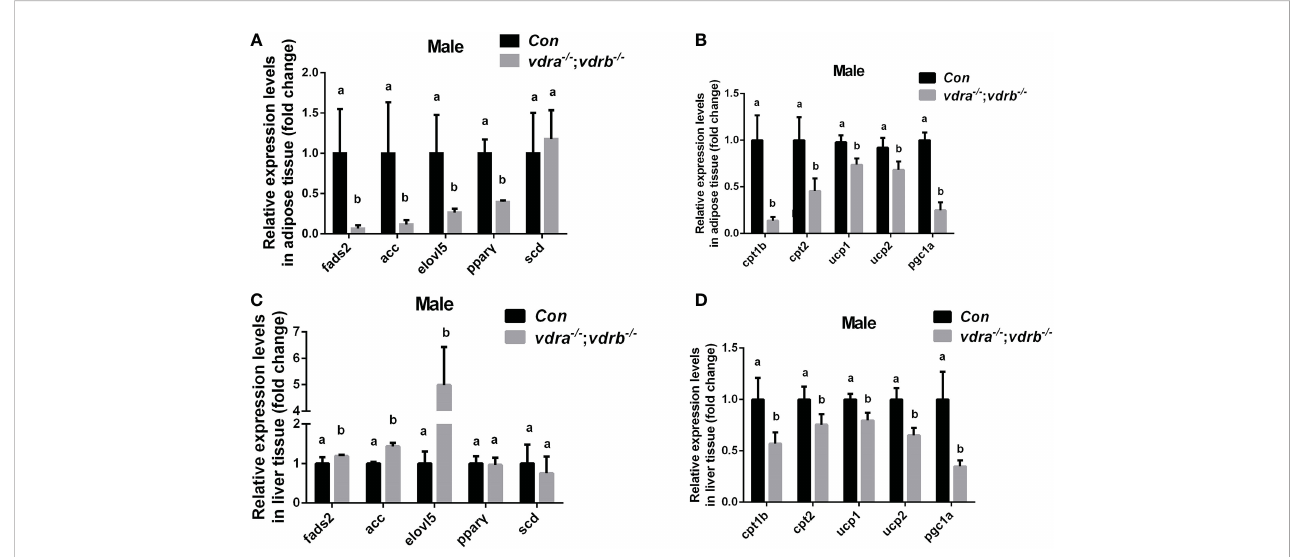
FIGURE 4 Transcriptional levels of maker genes involved in the lipogenesis and lipid oxidation. (A, C) Relative expression levels of marker genes involved in lipogenesis including fads2,acc,elovl5,ppar g and scd in adipose tissue (A) and liver tissue (C) of mutant line and control. Three biological repeats were carried out and statistical analysis was performed using a t test (n=3). (B, D) Relative expression levels of cpt1b, cpt2,ucp1, ucp2 and pgc1 a in adipose tissue (A) and liver tissue (C) of mutant line and control. Three biological repeats were carried out and statistical analysis was performed using a t test (n=3). There was no difference between the two internal reference gene ( b -actin and EF1 a ). The bars with different letters indicated signi fi cant difference